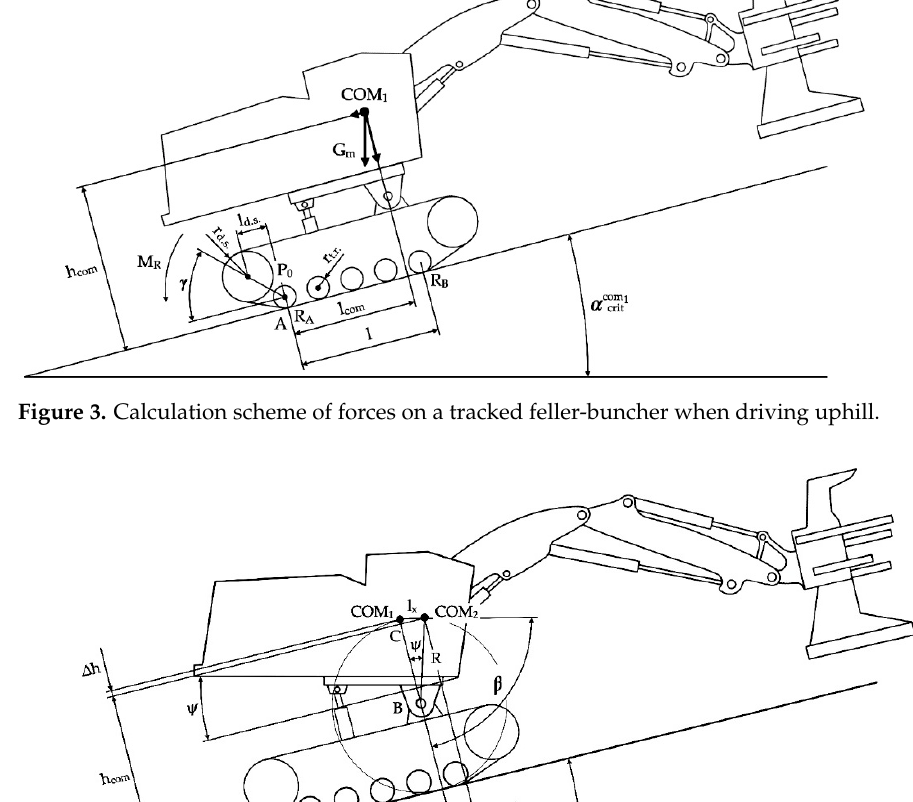
Figure 4. Calculation scheme of the shifting of the center of mass when tilting the platform.